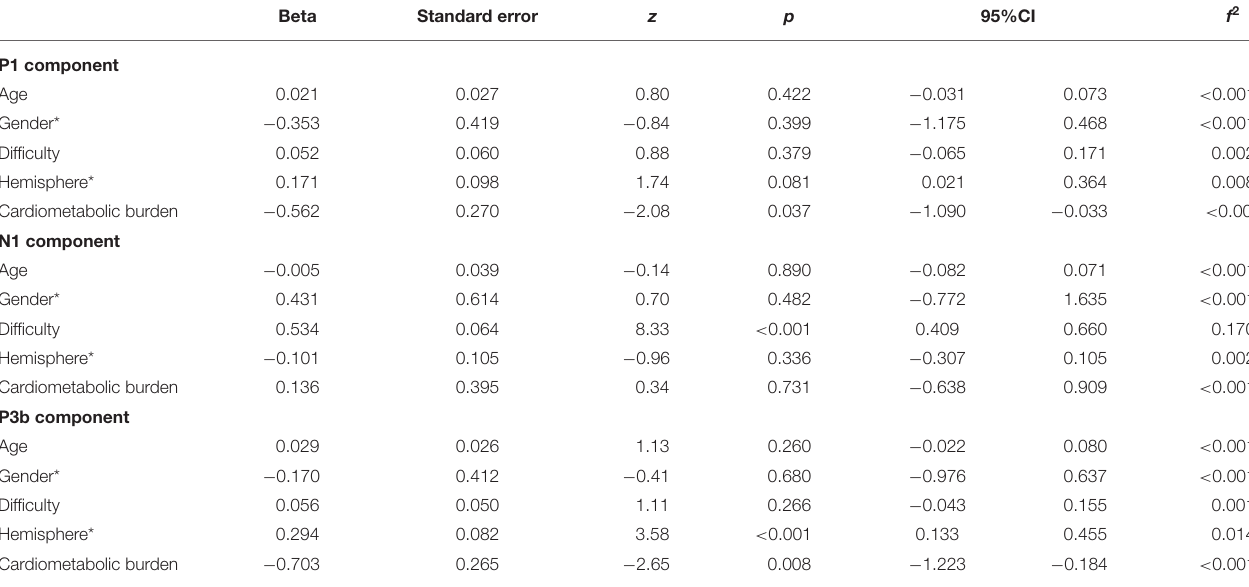
TABLE 3 | Results from mixed effects models for the P1, N1, and P3b ERP component amplitudes (primary analyses).